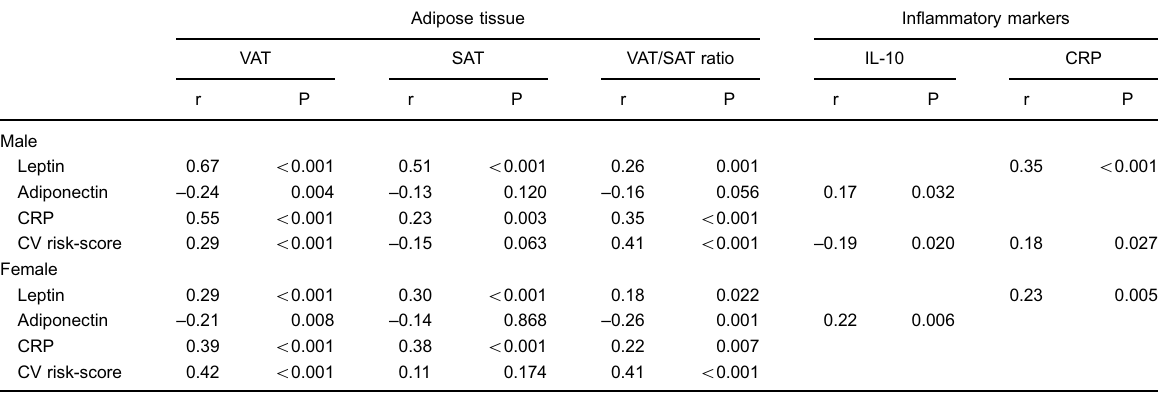
Table 2. Signi fi cant Spearman correlation coef fi cients (r) among VAT, SAT, VAT/SAT ratio, and in fl ammatory markers, and calculated CV risk-score according to gender (male, n=155; female, n=154). Adipose tissue In fl ammatory markers VAT